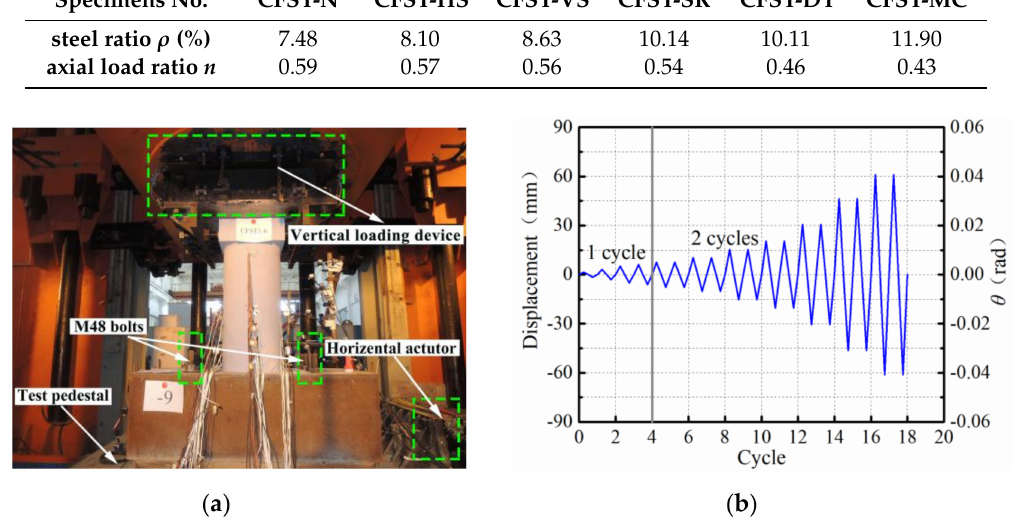
Figure 5. CFST column test. ( a ) Test site; and ( b ) typical cyclic loading